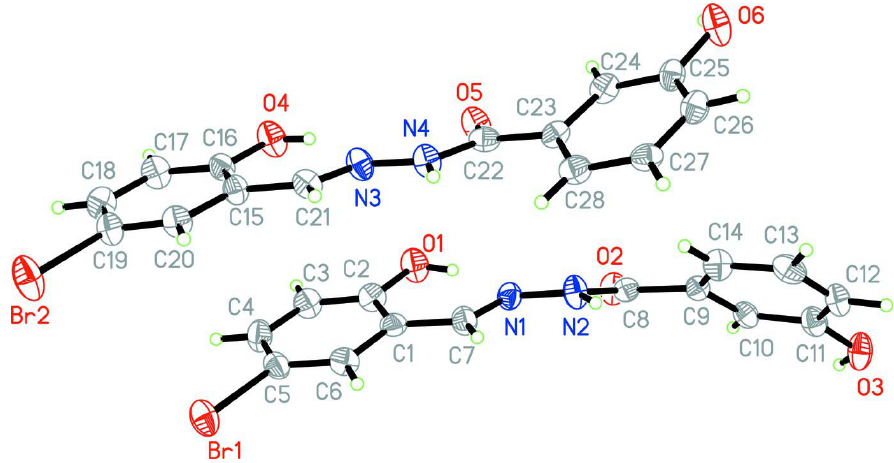
Figure 1 The molecular structure of the title compound with 30% probability ellipsoids.